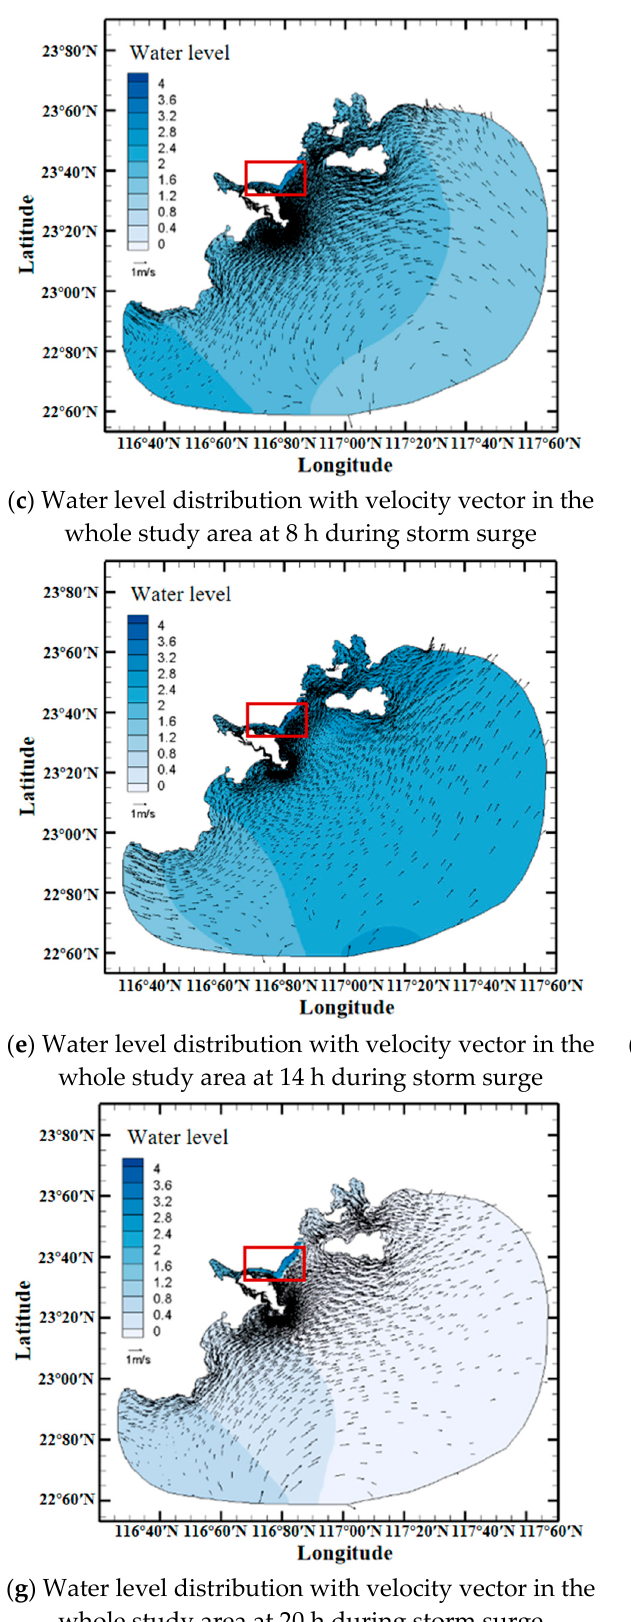
Figure 8. Tidal current field and inundation of typhoon storm in 10-year return period (The red box on the left is the simulation area on the right).